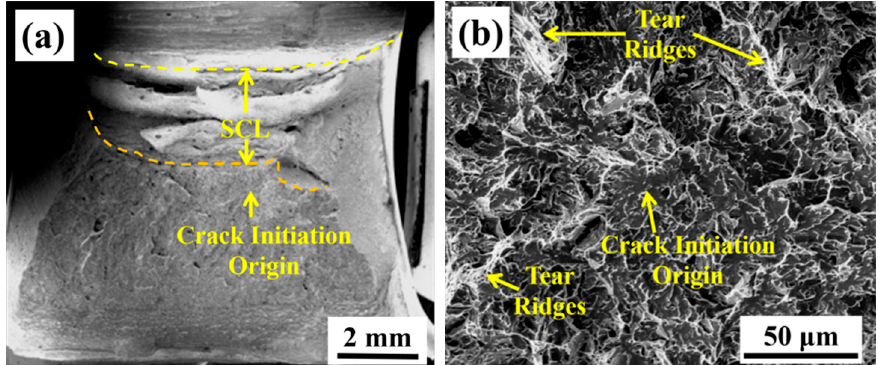
Figure 14. Fracture surface of HM specimen for ( a ) marco, ( b ) crack initiation origin. Materials 2020 , 13 , x FOR PEER REVIEW